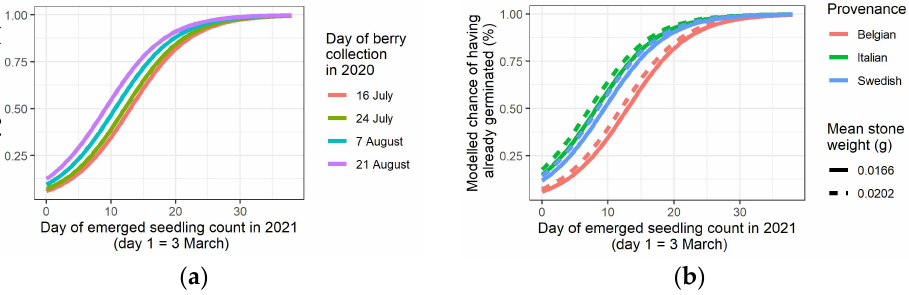
Figure 5. Modelled timing of seedling emergence in the spring of 2021, according to the day of berry collection in 2020 ( a ) and the provenance and mean stone weight ( b ).